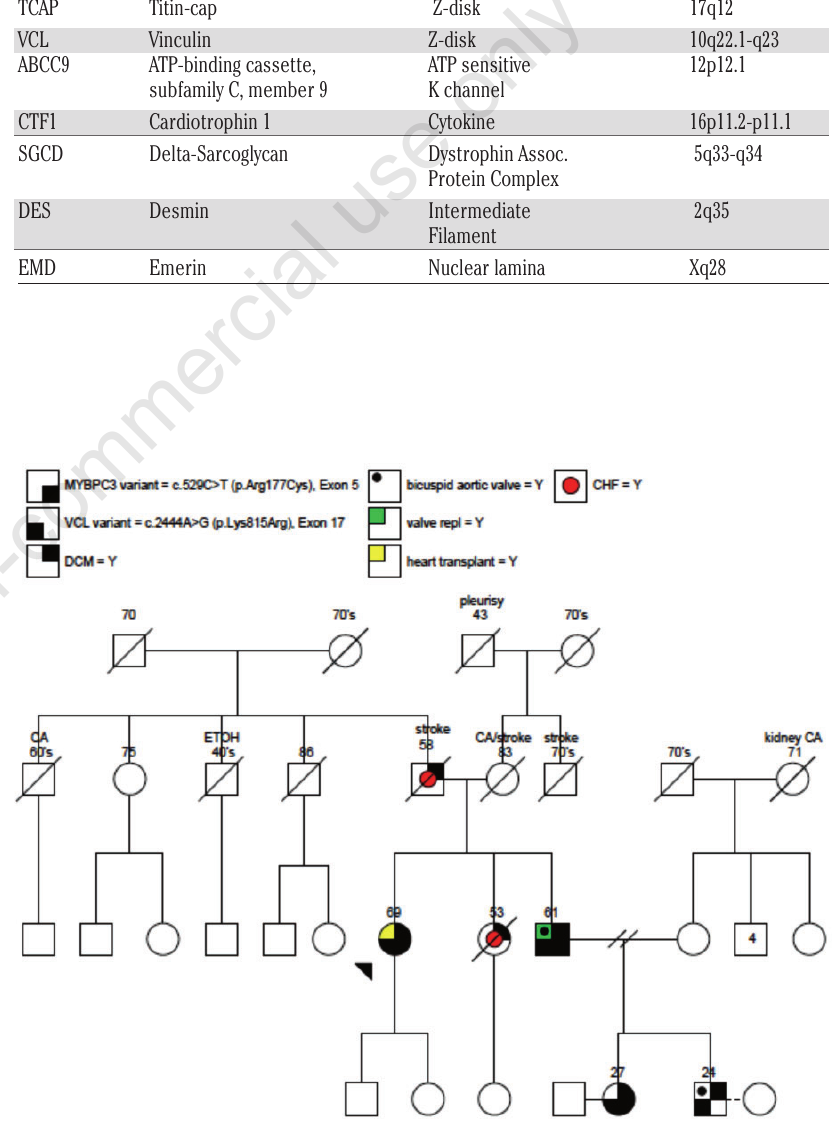
Figure 1. Pedigree of proband and affected family